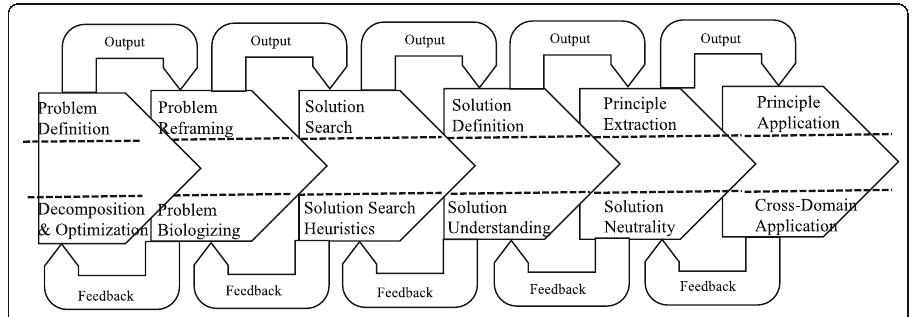
Fig. 1 Phases of scientific